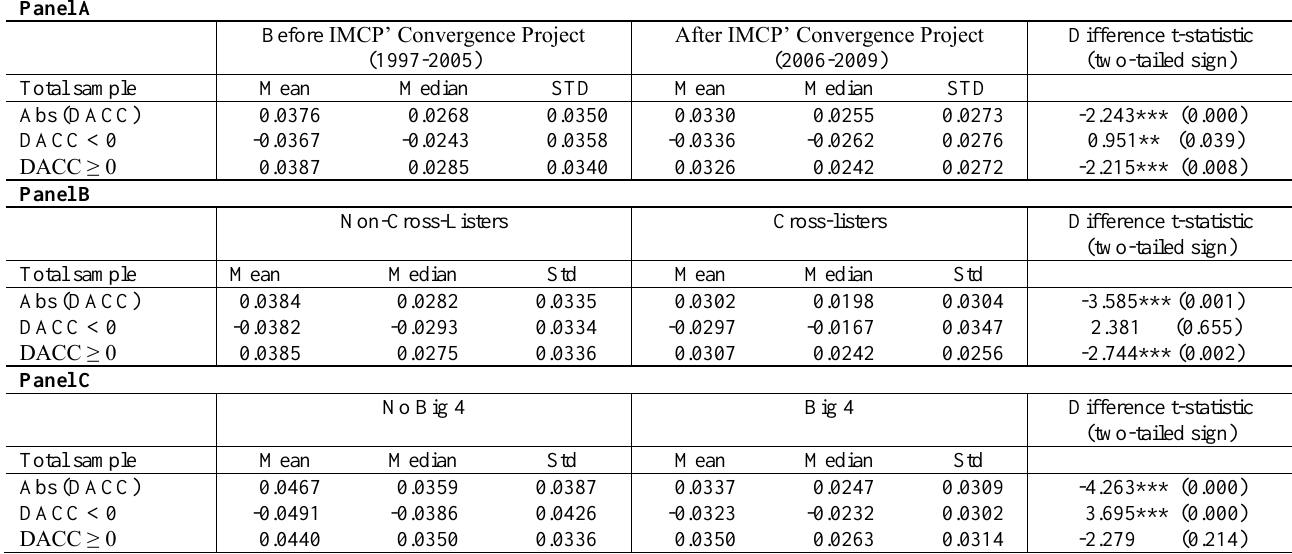
Table 4: Descriptive statistics on discretionary accruals Panel A